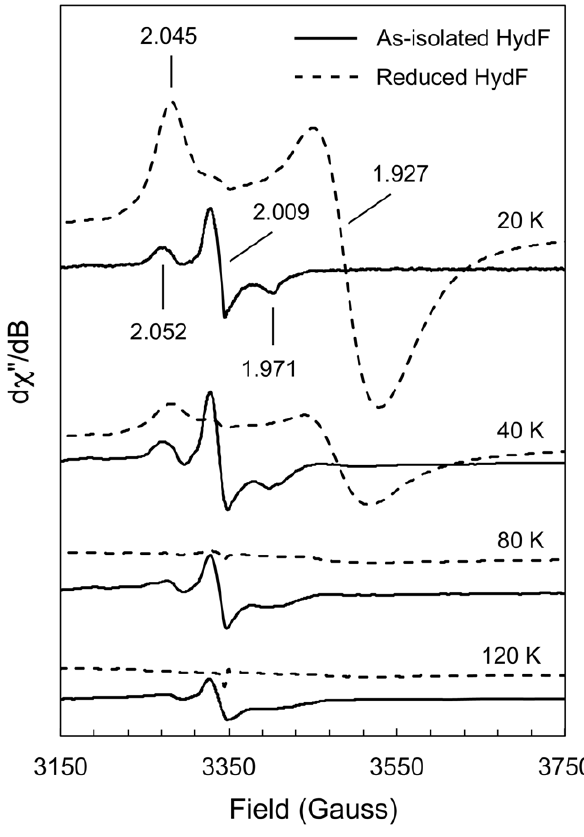
Figure 2. EPR spectroscopy of the Shewanellaoneidensis HydF maturase. Continuous-wave EPR measurements were obtained at an X-band frequency (9.39 GHz). Spectra for as-isolated HydF (1.2 mM, solid lines) were measured at 20 K (50 m W), 40 K (0.5 mW), 80 K (5 mW) and 120 K (50 mW). Spectra for DTH-reduced HydF (1.1 mM, dashed lines) were measured at 20 K (200 m W), 40 K (2 mW), 80 K (50 mW) and 120 K (50 mW). The g -values for each signal are indicated in the 20 K spectra. Intensities were normalized to the numbers of scans, temperature, receiver gain, conversion time, modulation amplitude, and square root of microwave power. All spectra are presented without magnification of the normalized intensities. Spectra identical to those for reduced HydF were observed at 20 K and 40 K for the HydF maturase reconstituted in vitro with Fe 2 + , S 2– , cysteine, PLP, and an E. coli lysate for 60 min prior to DTH reduction (0.80 spins per